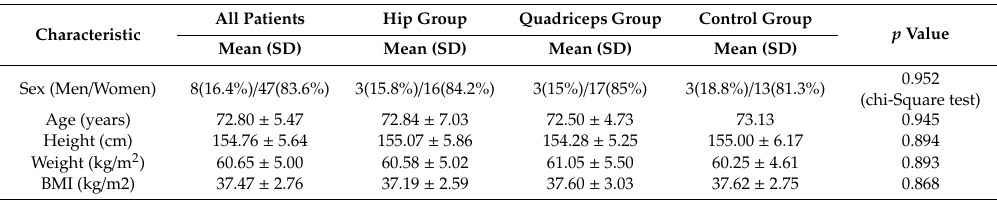
Table 3. General characteristics of participants ( n =